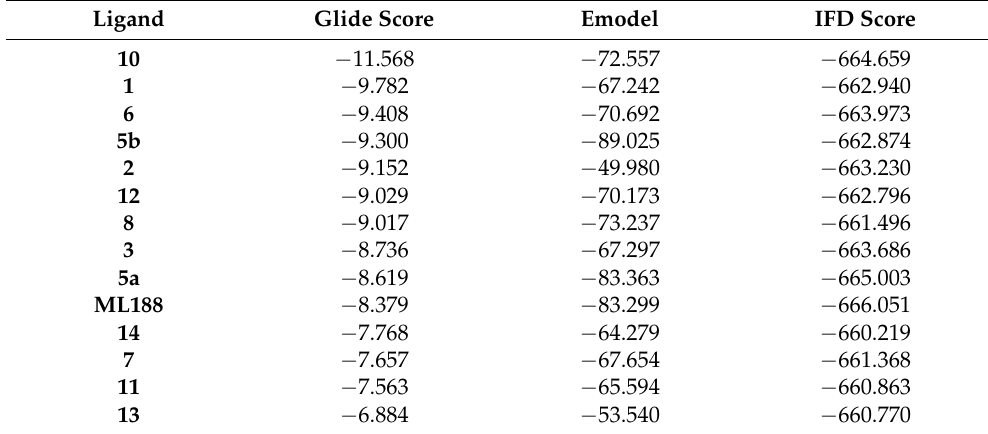
Table 2. Results of the molecular docking of (+)-usnic acid and its derivatives into the active site of the main protease SARS-CoV-2 in comparison with the co-crystallized inhibitor ML188.